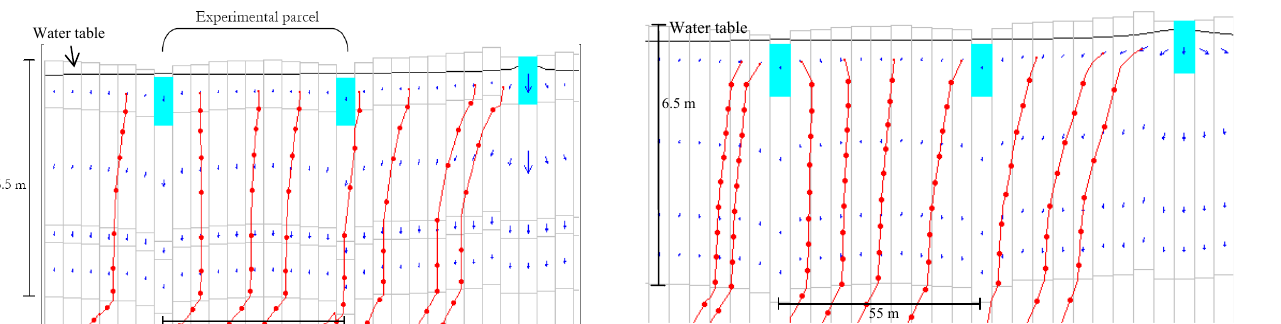
Fig. 10 Steady pathlines for downward flow for the heterogeneous case (b) lines are pathlines; each dot represents one year (b) blue boxes are ditches (c) blue arrows are velocity